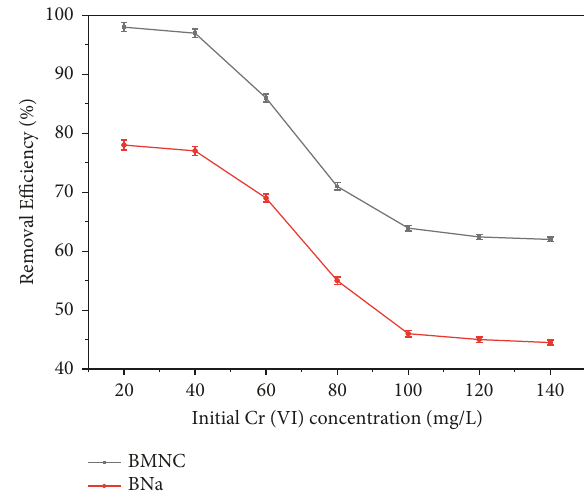
Figure 9: Effect of initial concentration on adsorption of Cr(VI) by bentonite (BNa) and nanocomposite adsorbent